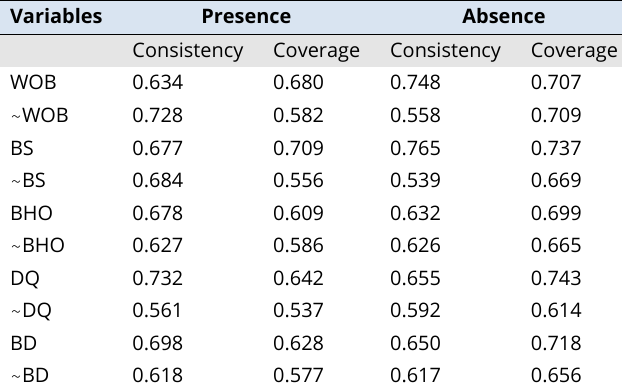
Necessary condition analysis of board characteristics on